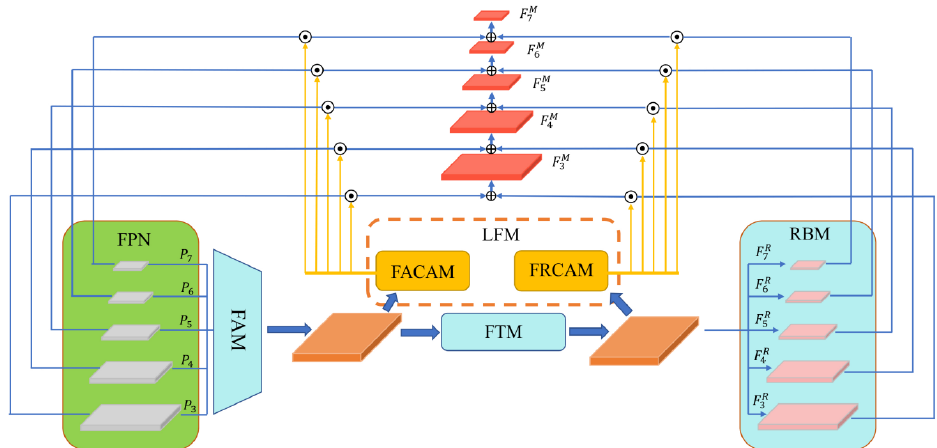
Figure 4. The overall structure of the